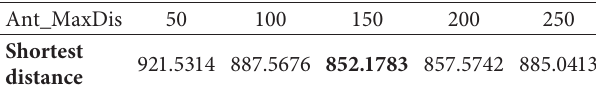
Table 6: Influence of different Ant_MaxDis on algorithm results.